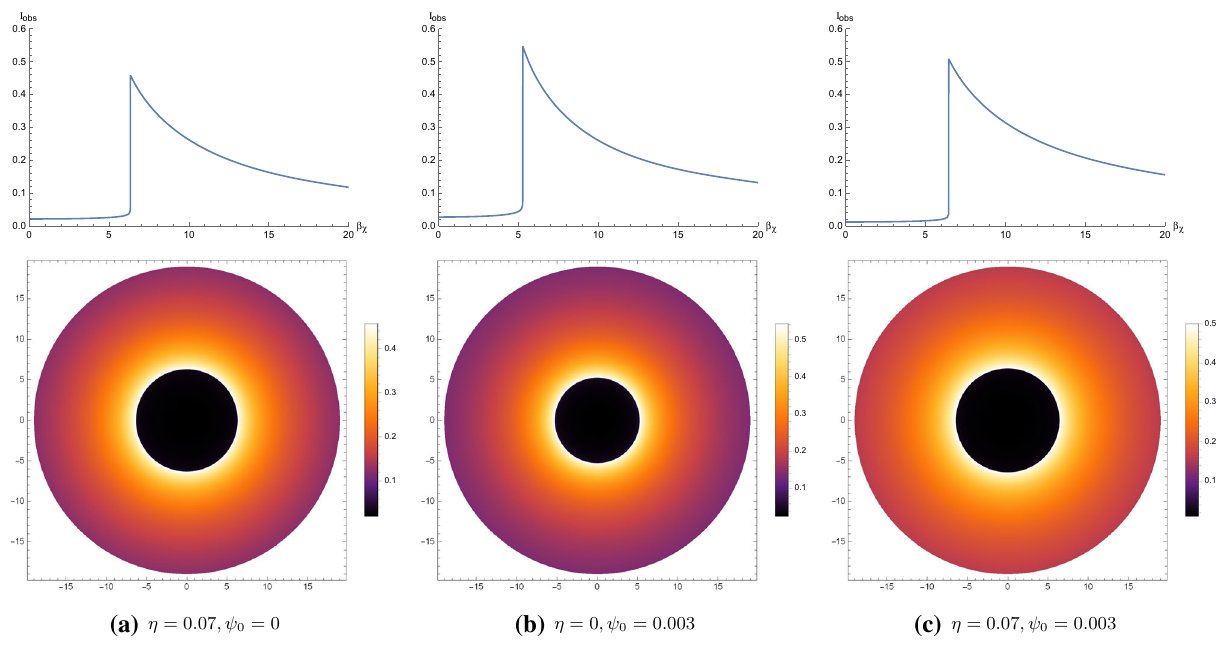
Fig. 9 The specific intensity I obs (ν o ) seen by a distant observer for an infalling accretion